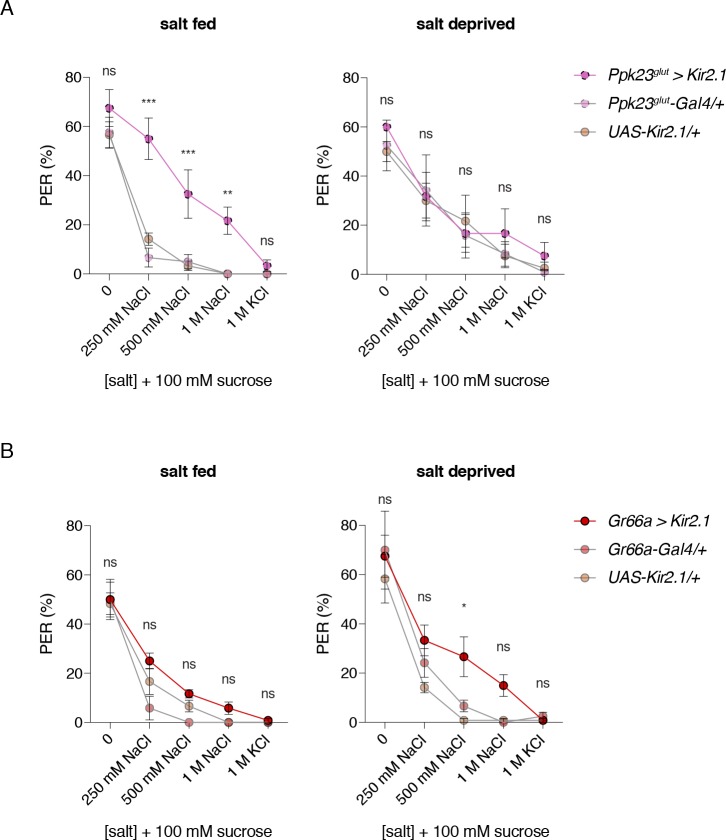
Ppk23glut and Gr66a GRNs differentially function in PER suppression by high salt, depending on internal state.(A–B) High salt inhibition of PER in salt fed (left) or salt deprived (right) flies following silencing of Ppk23glut (A) or Gr66a (B) GRNs. Labellar PER was measured to 100 mM sucrose plus the indicated salt. Flies were either salt fed or salt deprived prior to the experiment. Values indicate mean ±SEM. n = 4 groups of 10 flies for each genotype. Asterisks denote significance from both control groups by two-way ANOVA with Bonferroni post hoc test, **p<0.01, ***p<0.001. ‘Ppk23glut-Gal4’ indicates Ppk23-Gal4 with Gr66a-LexA and LexAop-Gal80; and ‘>' denotes Gal4 driving UAS-Kir2.1 with temporal restriction by tub-Gal80ts.